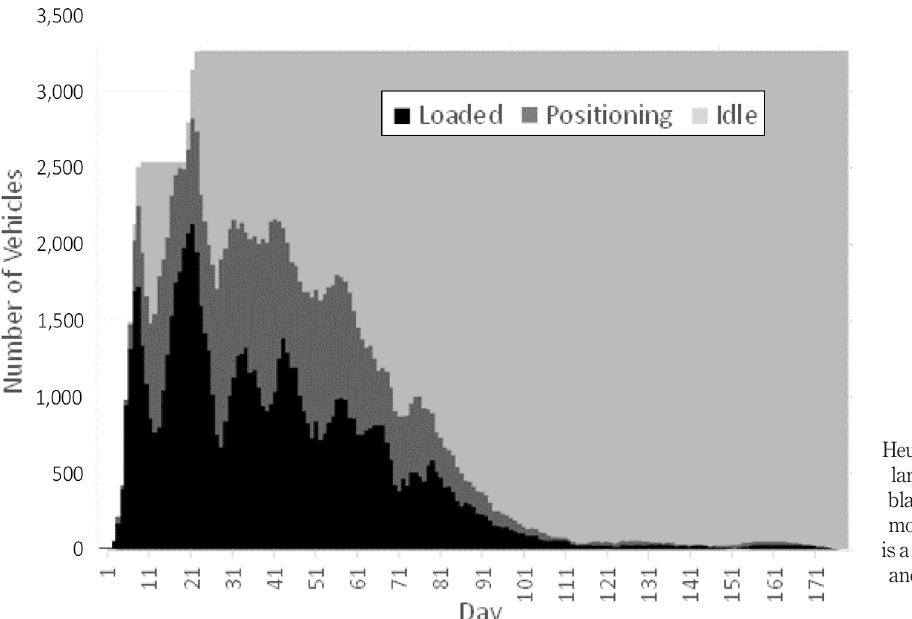
Figure 2. Heuristic solution